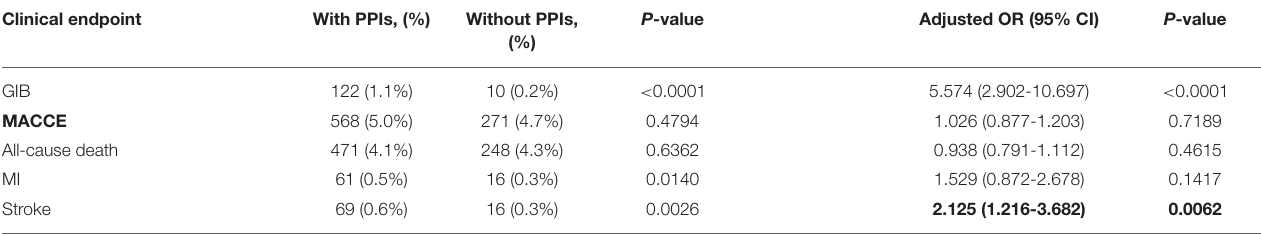
TABLE 2 | In-hospital endpoints incidence and adjusted OR among DAPT patients.